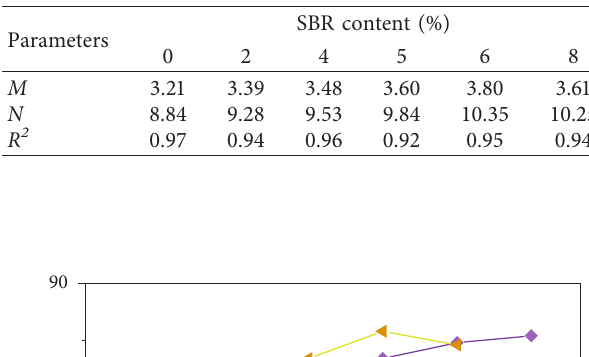
Table 5: The fitting results of the viscosity-temperature curve for BRA-SBR modified asphalt.